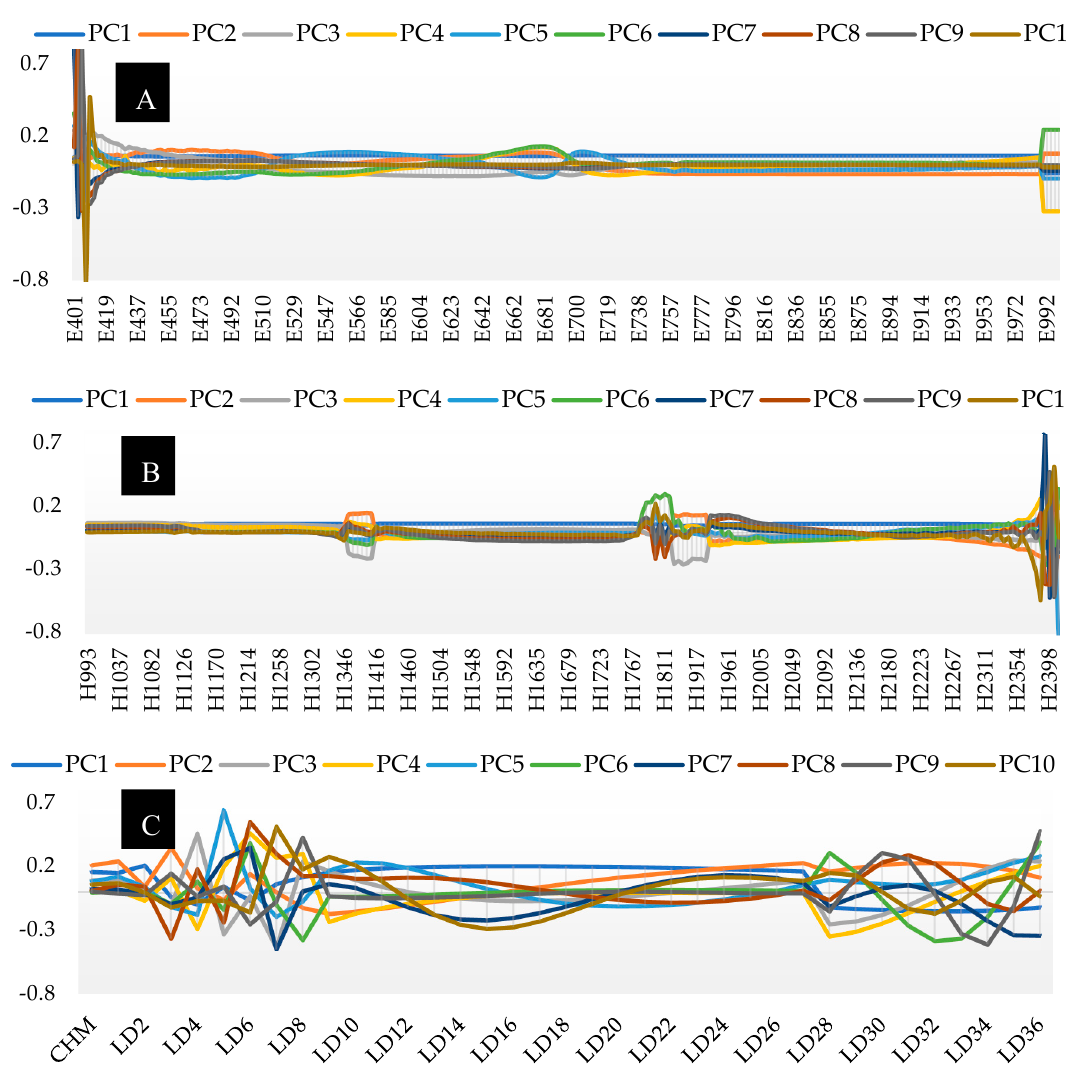
Figure 6. Factor loading (standardized) from each dataset, showing the linear contribution of each input variable to the PC bands: ( A ) Eagle sensor, ( B ) Hawk sensor, and ( C ) Lidar metrics.